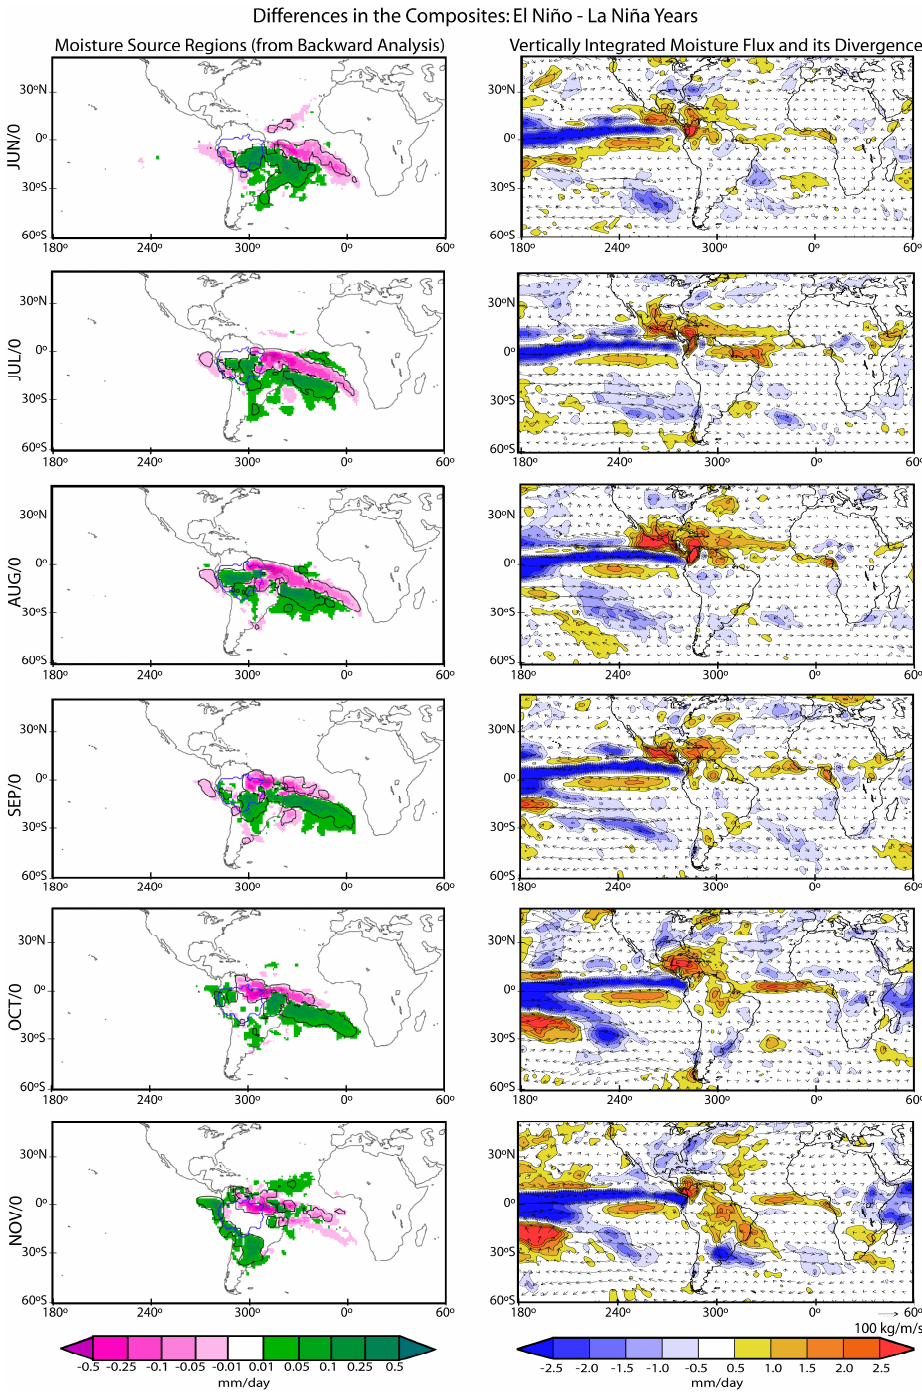
Figure 5. Left-hand column: monthly differences of composites of moisture sources of the Amazon Basin (considering only positive E − P values in the composites using backward analysis) for extreme ENSO episodes. Black contour lines indicate regions where the differences are significant at the 90% level according to the bootstrap test. Pink (green) colours indicate regions where the sources are more intense during El Niño (La Niña) years. Blue contour line indicates the basin area. Right-hand column: monthly differences in the vertically integrated moisture flux (vectors; measured in kgm − 1 s − 1 ) and its divergence (shade; measured in mmday − 1 ) between the composites for El Niño and La Niña years. Data obtained from